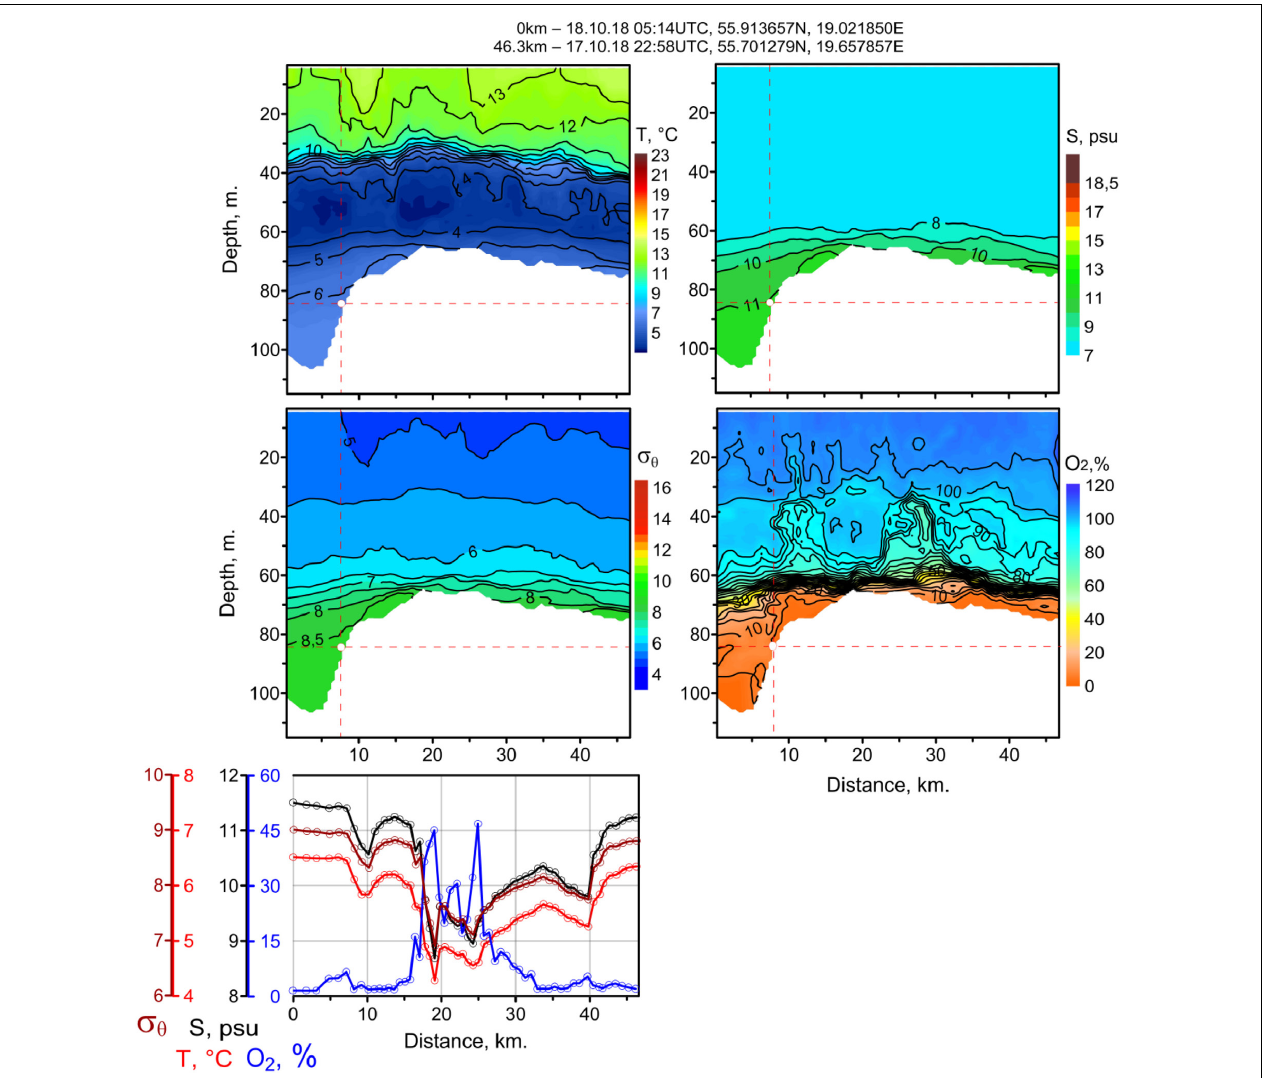
FIGURE 13 | Distributions of temperature T ( ◦ C), salinity S (psu), density σ θ , and oxygen saturation O 2 (%) in a transect across the eastern rim of the Hoburg Channel passing through the TCMs deployment site. Position of the TCMs on the transect is marked by a small white bullet intersected by dashed lines. Bottom panels demonstrate graphs of the same parameters in the bottom